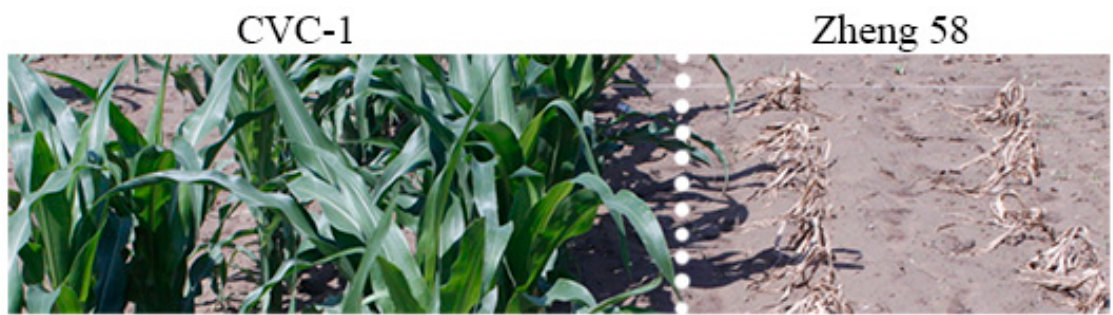
Figure 4. Glyphosate tolerance of the transgenic maize CVC-1 in the field. Non-transgenic maize Zheng 58 at the same growing stage was used as a control. The pictures were taken two weeks after glyphosate application.